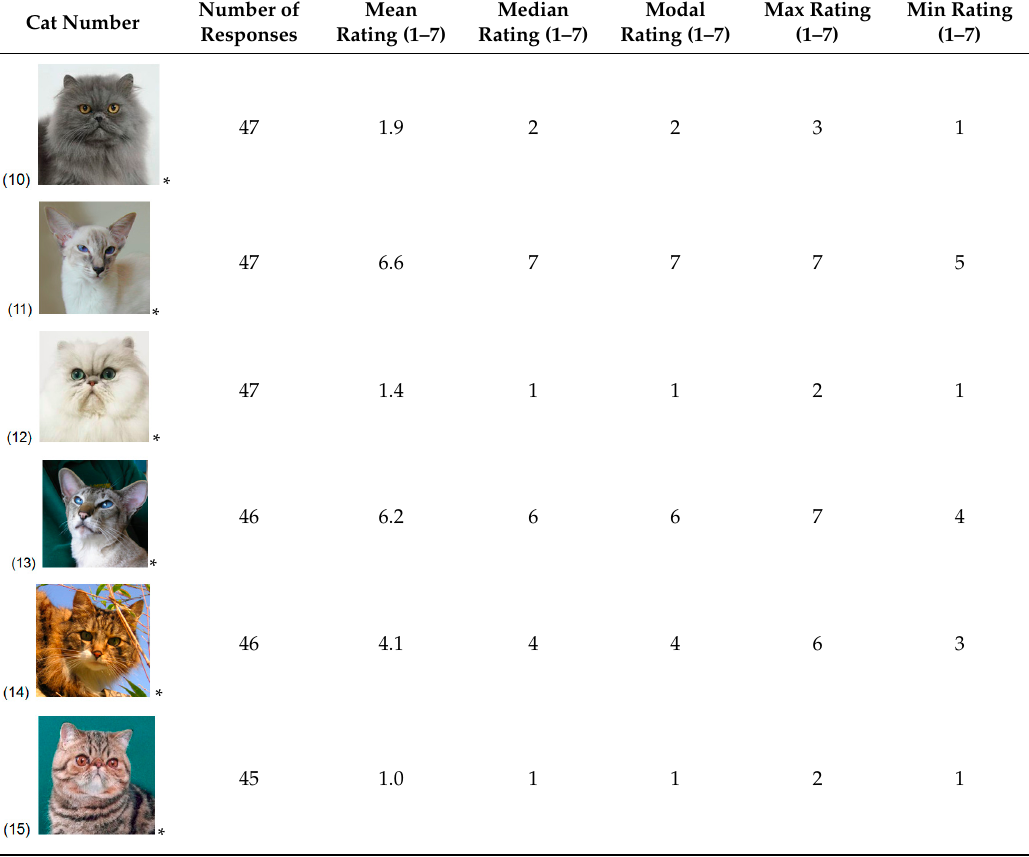
Figure 1. Preference ratings (0 = “I don’t like this cat at all”; 10 = “this is my favorite type of cat”) from 1239 cat owners for n = 15 cat images based on cephalic grouping, which was ascribed by expert ( n = 50) consensus (as per Table 1). Cephalic groupings range from extreme brachycephaly through to extreme dolichocephaly.